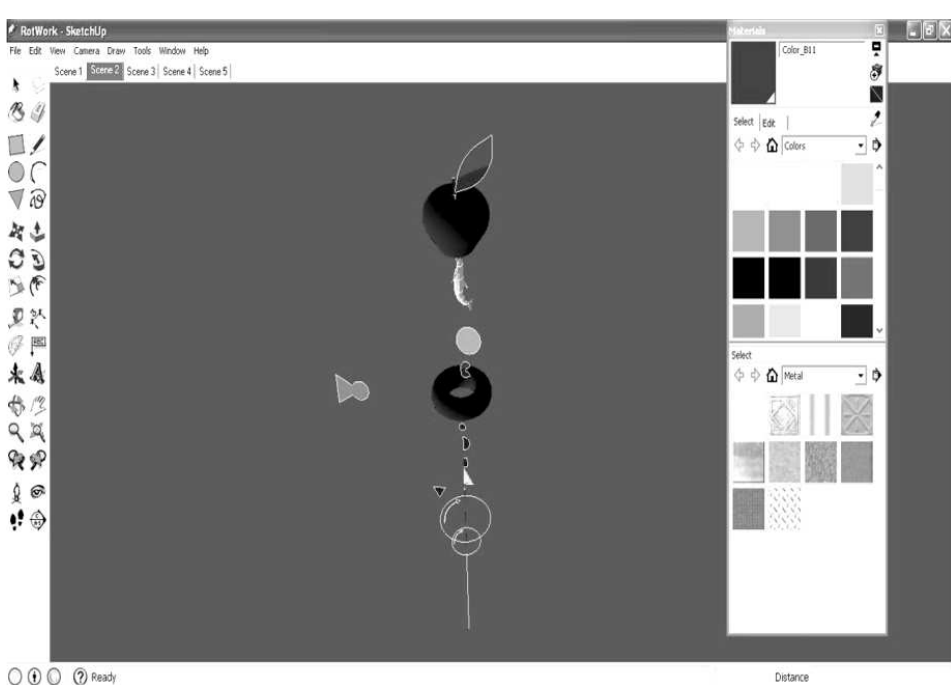
Figure 4: Supporting (cid:222) le for “Rotating Bodies” Source: Toncheva, N. (2011). Google SketchUp as a Tool of Computer Assisted Learning in Different Subjects, Journal of International Scienti (cid:222) c Publication: Education, Researches & Development , 9 (2 ),